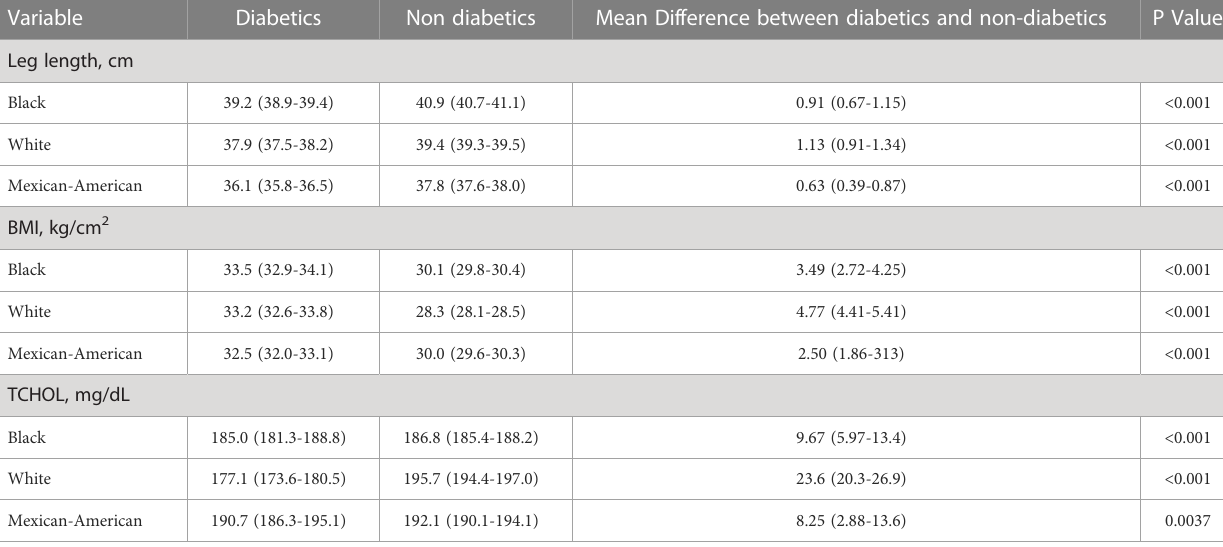
TABLE 1 Comparative mean leg length, BMI and TCHOL in diabetics and non-diabetics. Variable